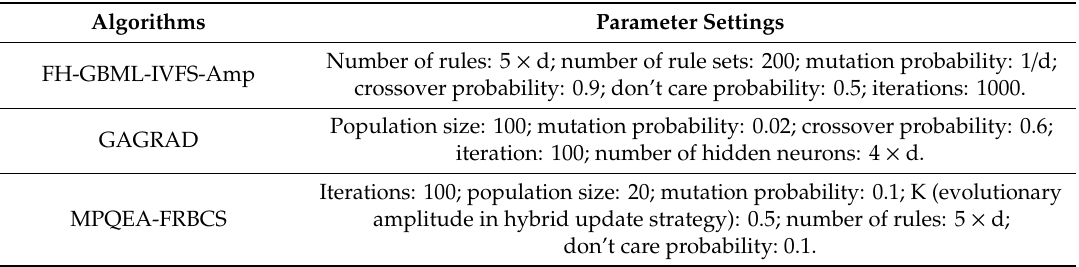
Table 5. Parameter settings of considered